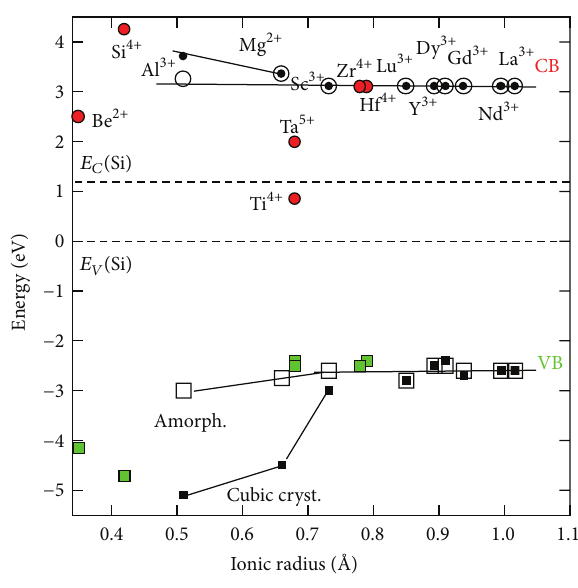
Figure 15: Energies of the VB top and CB bottom in different oxide insulators as a function of metal cation radius referenced to the band edges of the Si crystal as inferred from the IPE